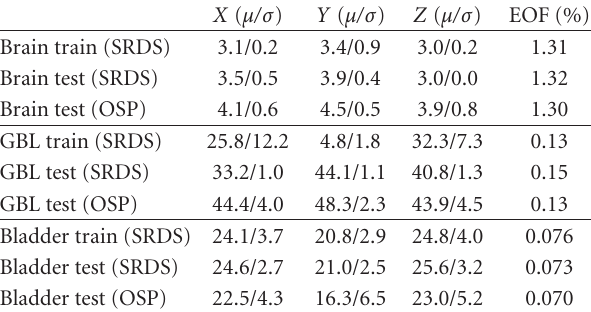
Table 3: Sparsity ( μ/σ ) and accuracy